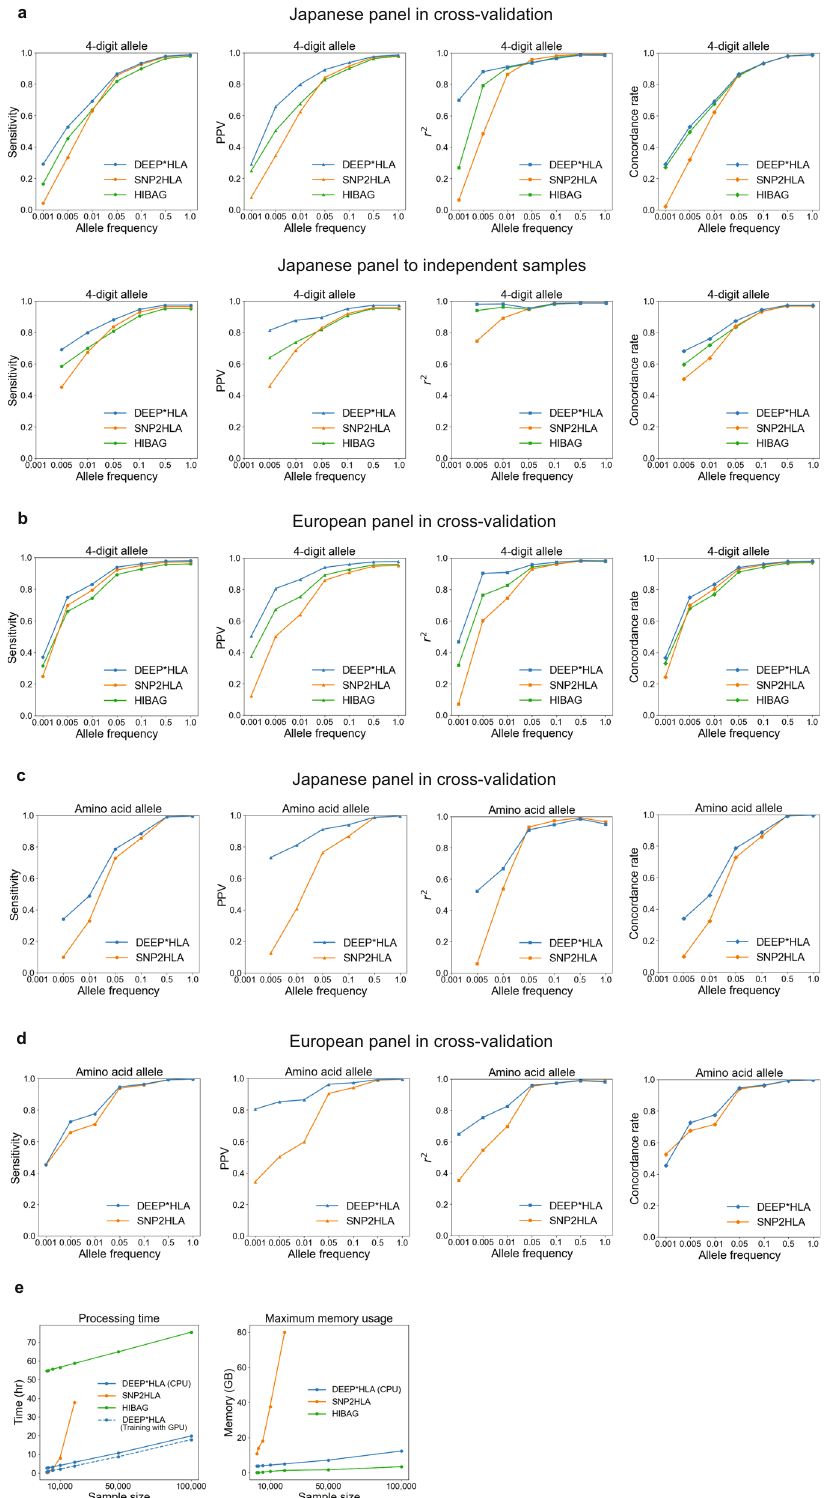
Fig. 2 Performance evaluations of HLA imputation methods. a – d Sensitivity, PPV, and r 2 of allelic dosage and concordance rate of best-guess genotypes for the 4-digit alleles ( a , b ) and amino acid polymorphisms ( c , d ) evaluated in our Japanese reference panel ( a , c ) and the T1DGC reference panel ( b , d ). For each metric, mean values of alleles with a frequency less than a value on the horizontal axis are shown on the vertical axis. DEEP*HLA was advantages especially for rare alleles. e Processing time (left) and maximum memory usage (right) evaluated on imputing BBJ samples using the Japanese panel. DEEP*HLA imputed the fastest in total processing time as the sample size increased. The dashed blue line in the processing time represents a case when DEEP*HLA used GPU only in training a model. All methods exhibited maximum memory usage scaling roughly linearly with sample size. SNP2HLA did not work within 100 GB in our machine for the sample sizes greater than 20,000. Source data are provided as a Source Data fi le. PPV, positive predictive